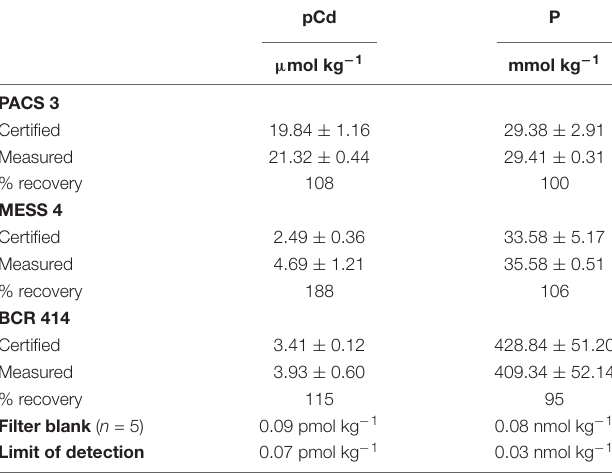
TABLE 2 | Results for pCd and P from the ICP-MS analysis of PACS 3, MESS 4, and BCR 414 certified references